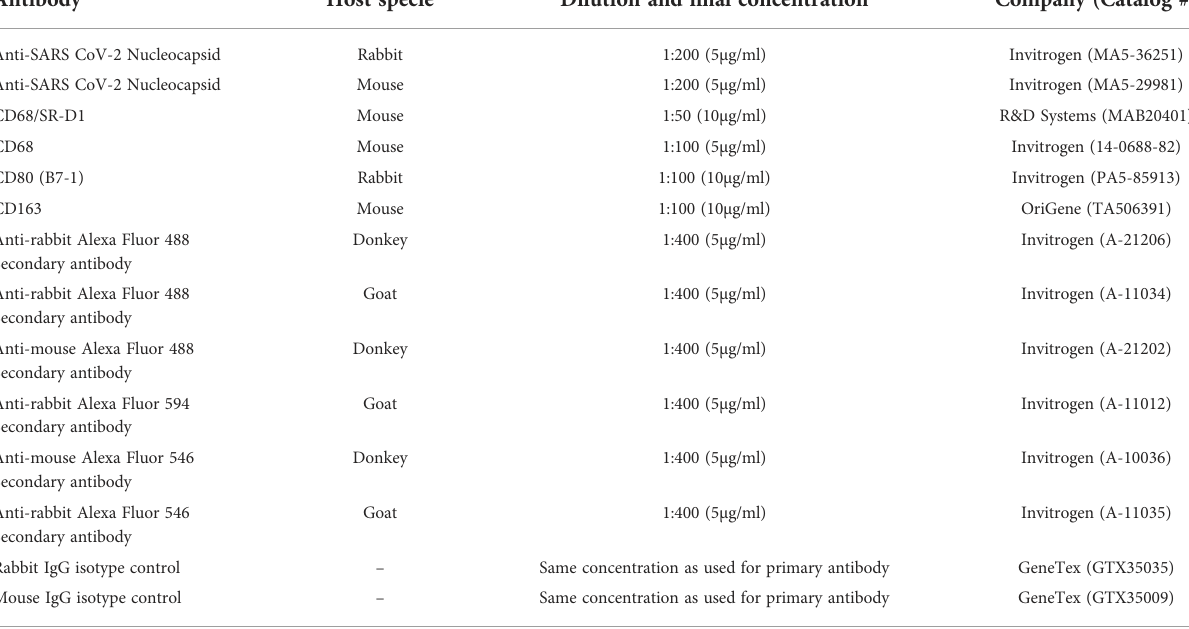
TABLE 1 Antibodies used for immunostaining. Antibody Host specie Dilution and fi nal concentration Anti-SARS CoV-2 Nucleocapsid Anti-SARS CoV-2